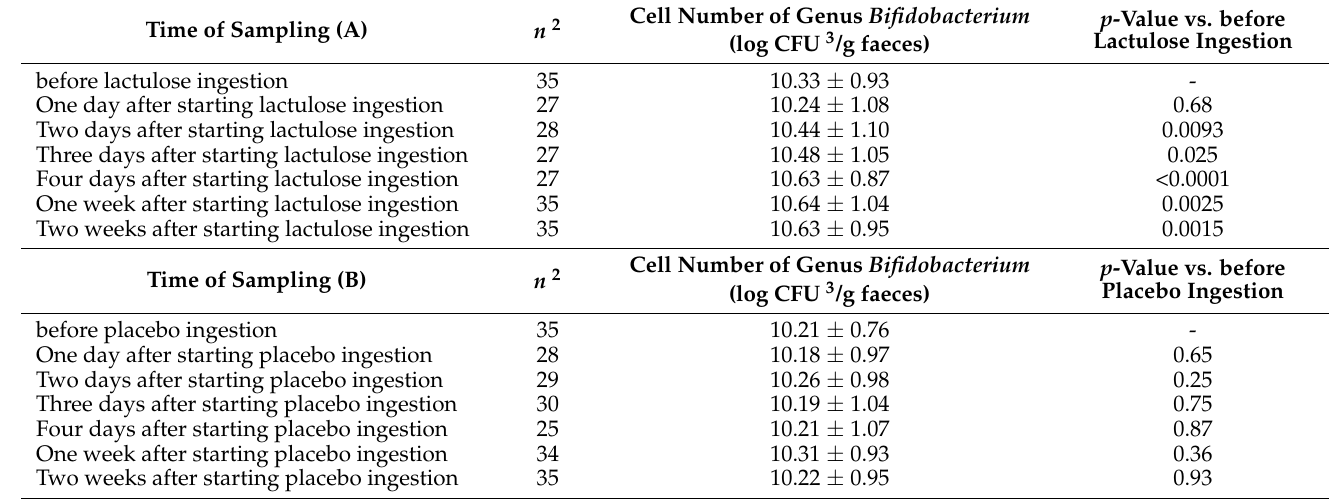
Table A3. ( A ). Transition in the cell numbers of the genus Bifidobacterium during lactulose ingestion 1 . ( B ). Transition in the cell numbers of the genus Bifidobacterium during placebo ingestion 1